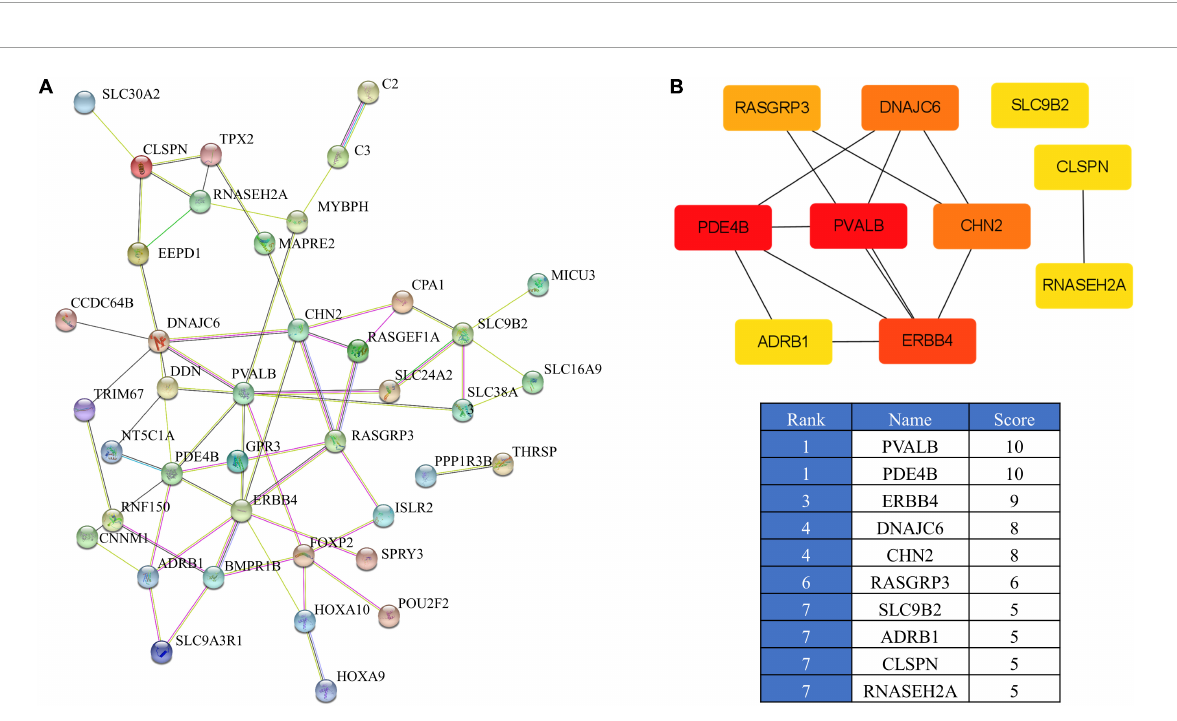
FIGURE5 PPI network of the overlapping genes. (A) PPI analysis of 47 overlapping genes from IMF_H vs. IMF_L comparison according to the STRING database. (B) PPI network of the top 10 hub genes visualized using